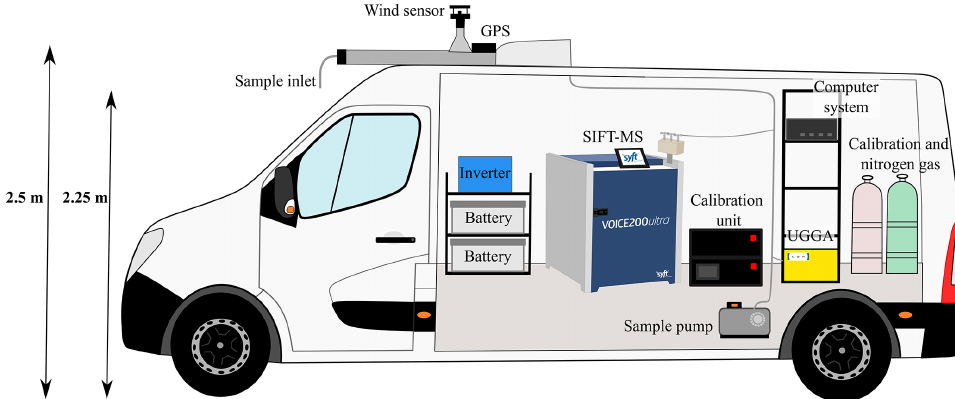
Figure 1. A graphic of the WACL Air Sampling Platform (WASP) used for mobile measurements. Table 1. Details of the WASP instrumentation. Instrument Time Compounds Power